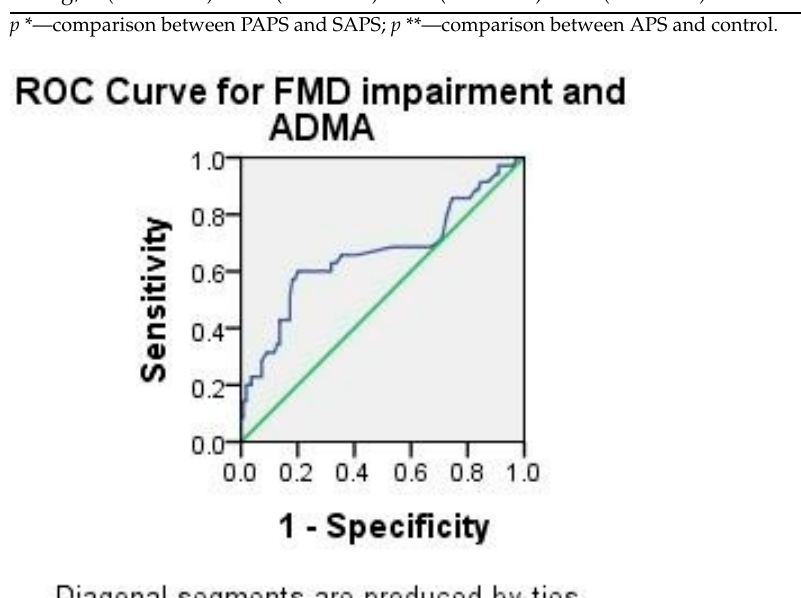
Figure 1. ROC analysis for ADMA and FMD impairment. In the control group, no significant correlations between ADMA concentration and risk factors (BMI, hypertension, diabetes, smoking habit, or lipid fractions) were found. In the PAPS group, ADMA concentration correlated to age ( ρ 0.376, p = 0.003), presence of hypertension ( ρ 0.485, p = 0.001), and smoking habit ( ρ 0.297, p = 0.024). In the SAPS group, ADMA correlated to SLEDAI ( ρ 0.480, p = 0.001), a high titer of B2IgG ( ρ 0.193, p = 0.049), and to any positivity of aCL IgG ( ρ 0.208, p = 0.033). The concentration of hsCRP correlated to FMD impairment ( ρ 0.181, p = 0.033). Figure 2 shows the ROC curve for hsCRP and FMD impairment (AUC 0.624, p = 0.033, 95% CI 0.526–0.722). The discriminative hsCRP cut off value of 0.96 had a sensitivity of 72% and a specificity of 51% for FMD impairment. The concentration of hsCRP in the control group showed strong correlations to lipid fractions: cholesterol ( ρ 457, p = 0.008), triglycerides ( ρ 0.685, p = 0.001), HDL ( ρ − 0.695, p = 0.001), and LDL ( ρ 0.619, p = 0.001), and a weaker correlation to hypertension ( ρ 0.390, p = 0.016) and smoking habit ( ρ 0.430, p = 0.007). In the APS group, hsCRP correlated to a medium/high titer of B2GPI IgG ( ρ 0.225, p = 0.024) and triple aPL positivity ( ρ 0.233, p = 0.019), but there was no significant correlation to the clinical manifestation of